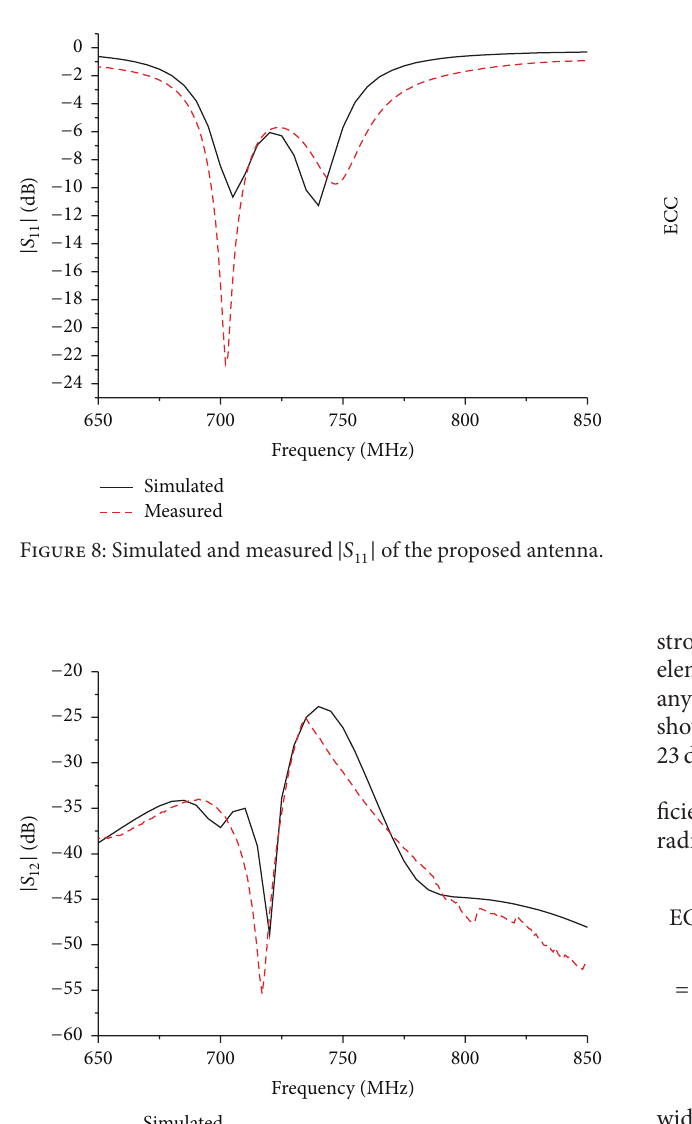
at the higher frequency. As shown in Figure 7(b), there are more currents distributing on the ground plane, and that is because of the good stability of PIFA.